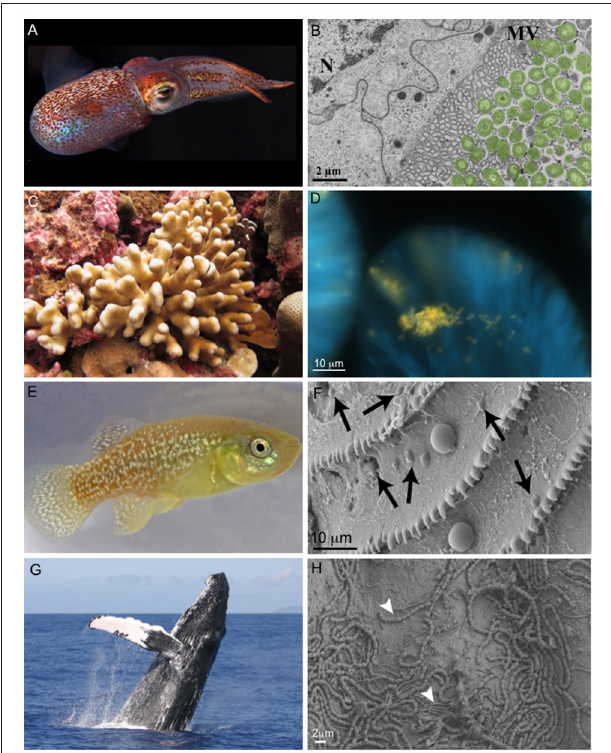
FIGURE 3 | Photographs of marine animals and their associated microbiomes from select study systems. Photographs include: the Hawaiian bobtail squid Euprymna scolopes (A) and a transmission electron micrograph of Vibrio fisheri cells associating with dense microvilli (MV) and in proximity to the epithelial nucleus (N) within the light organ (B) ; the reef-building coral Stylophora pistillata (C) and a microscopy image of Endozoicomonas cells (probed yellow using in situ hybridization) within the tentacles of a S. pistillata host (D) ; the Atlantic killifish ( Fundulus heteroclitus ) (E) and a scanning electron microscopy (SEM) image of the surface and scales of the fish, with arrows pointing to bacterial-sized cells and larger cells (which are not noted) are presumably phytoplankton (F) ; a humpback whale ( Megaptera novaeangliae ) breaching (G) and a scanning electron microscopy image of a humpback’s skin surface associated bacteria, with arrows indicating two different cell morphologies (H) . Photographs (A,B) were produced by M. McFall-Ngai and were previously published photographs ( McFall-Ngai, 2014), (C,H) were previously published by the author Neave et al. (2016) and Apprill et al. (2014), photograph (D) was taken by Liping Xun and photograph (E) by Evan